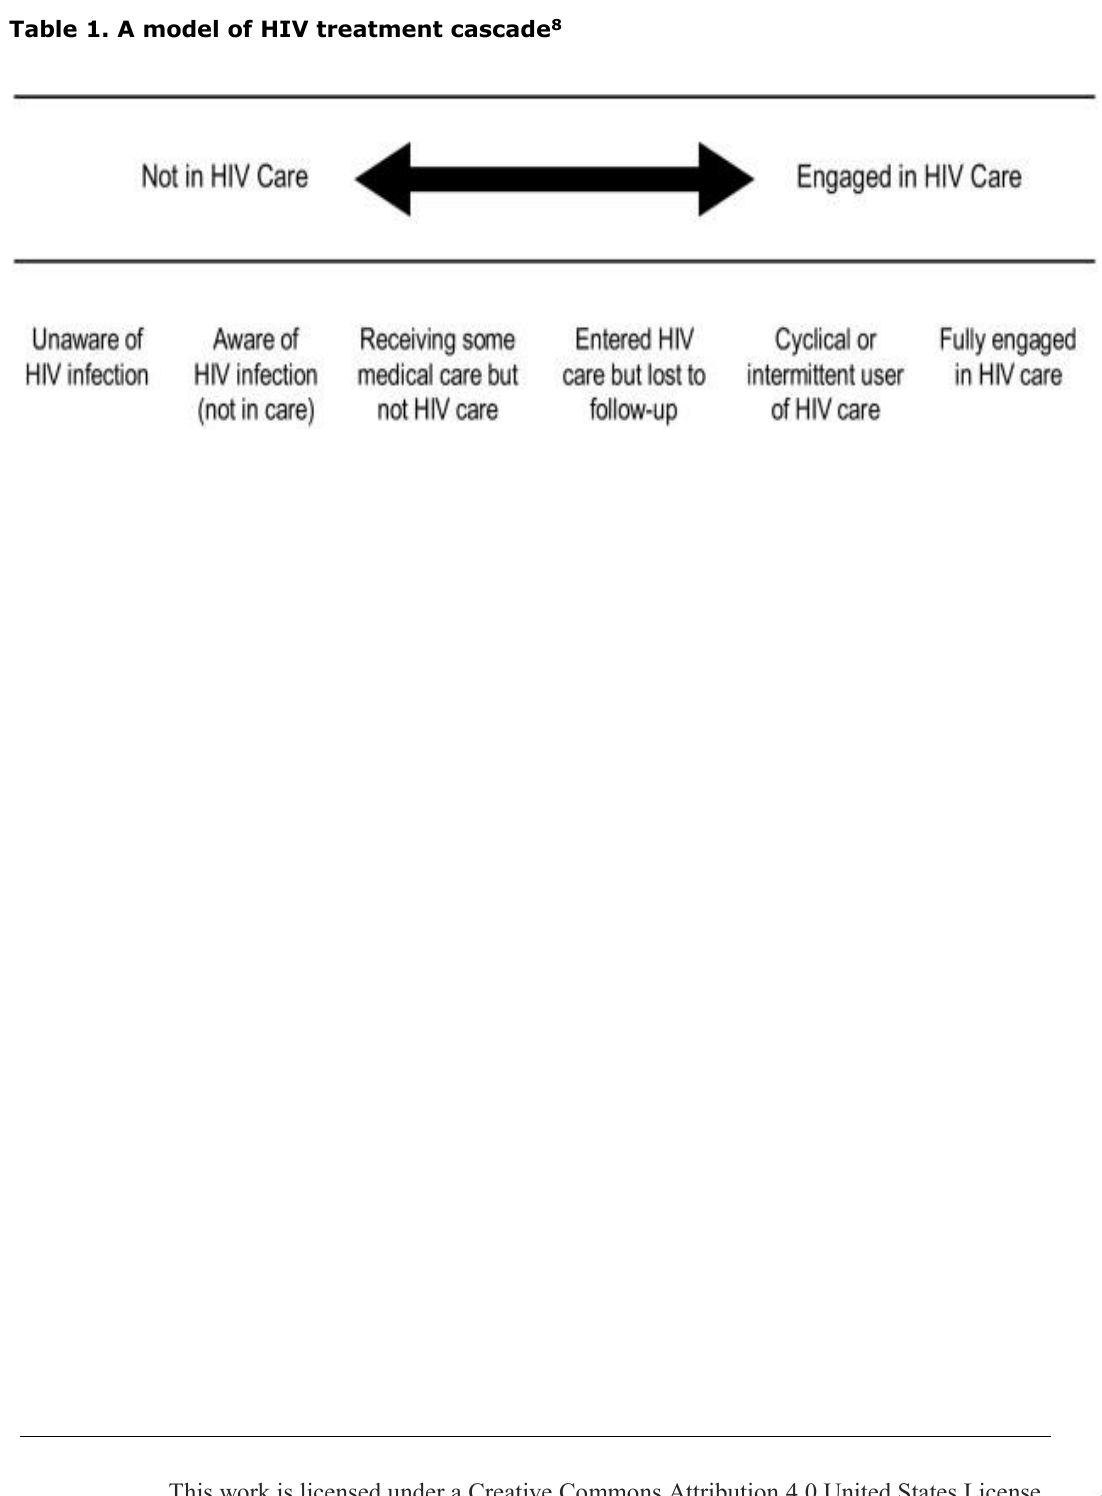
Table 1. A model of HIV treatment cascade